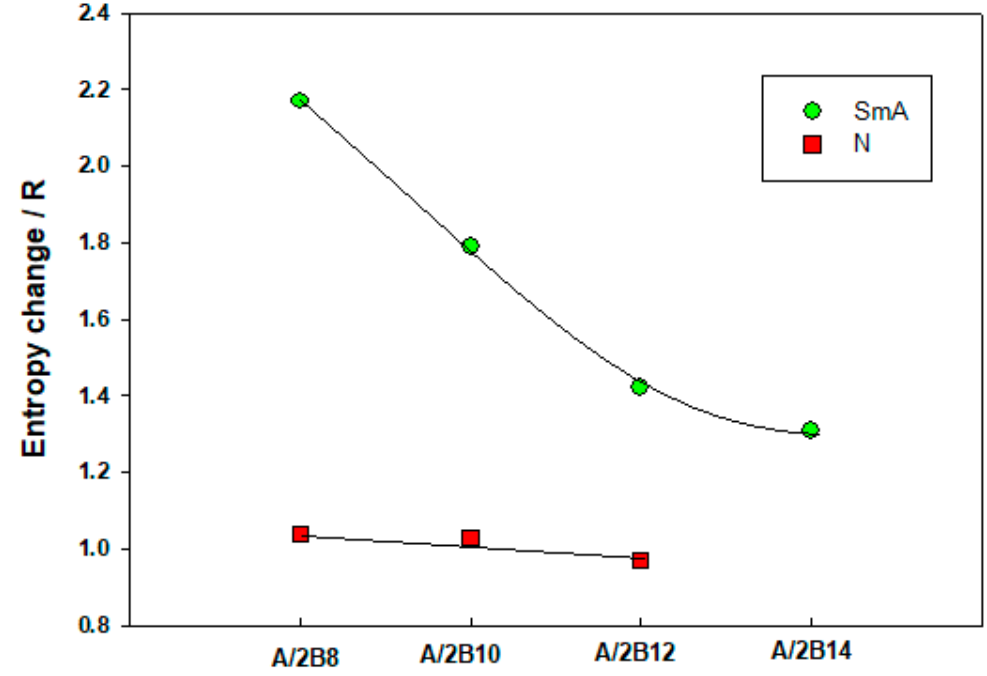
Figure 5. Entropy changes with the alkoxy chain length (n) of present SMHBLC complexes A/2Bn .